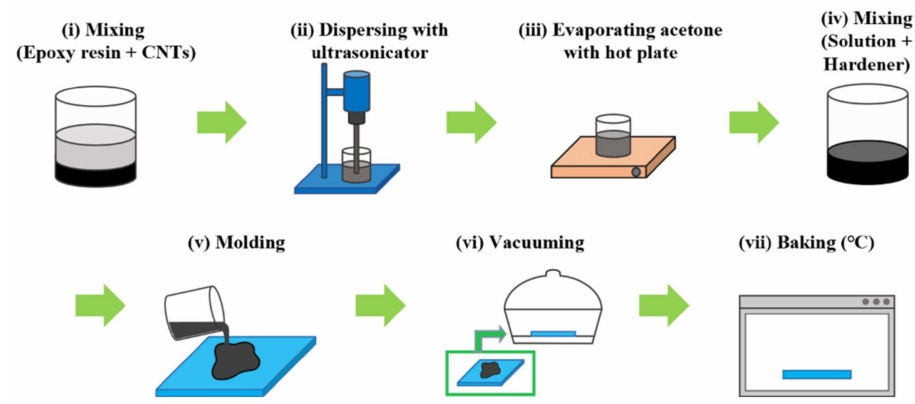
Figure 1. Fabrication of CNT/EP